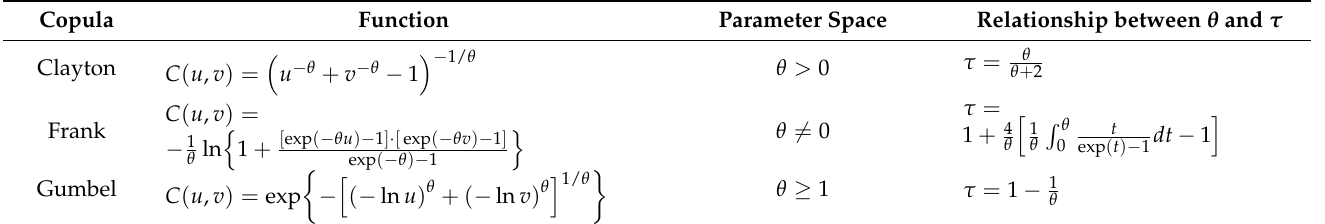
Table 1. Three copula functions used in this study and the relationships between θ and τ for these functions. Function Parameter Space Relationship between θ and